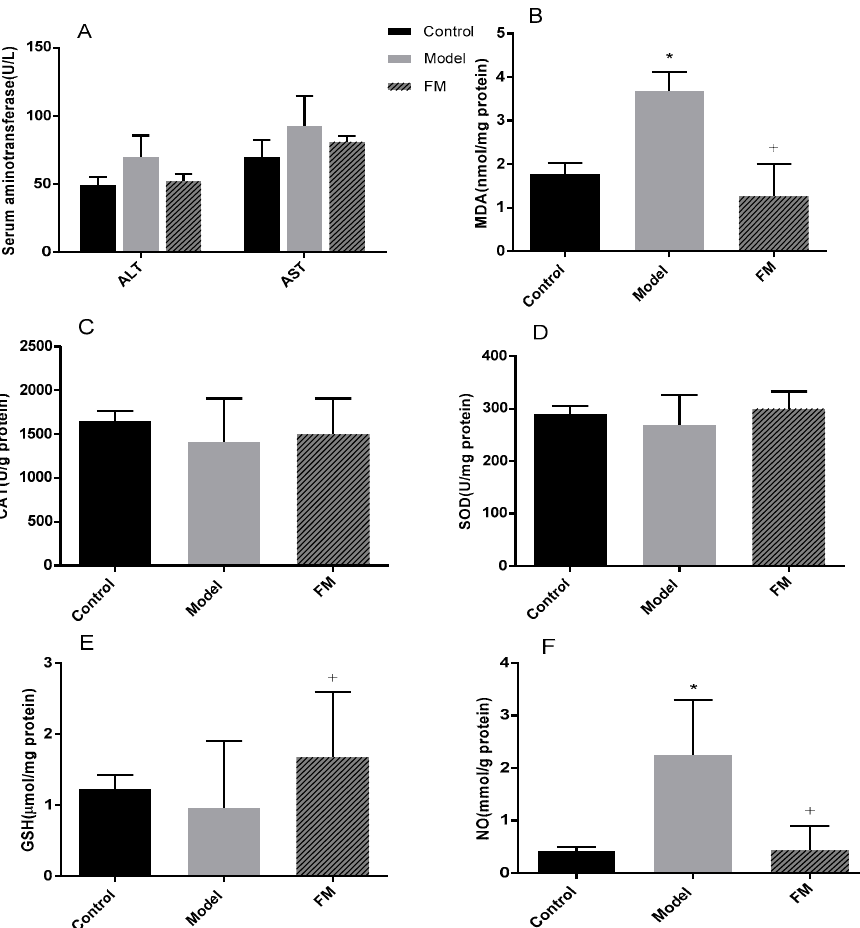
Figure 3. Effects of FM on serum ALT and AST activities ( A ), hepatic MDA content ( B ), CAT activity ( C ), SOD activity ( D ), GSH ( E ) and NO ( F ) contents. * p < 0.05 vs. control group. + p < 0.05 vs. model group.